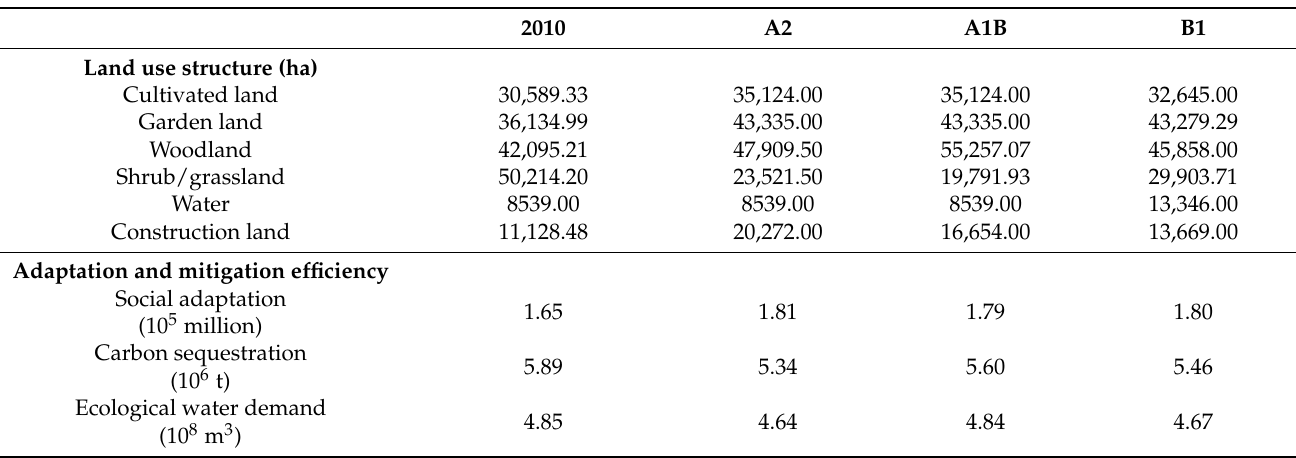
Table 7. Land use structure and climate change adaptation and mitigation efficiency in 2010 and future scenarios of Huailai